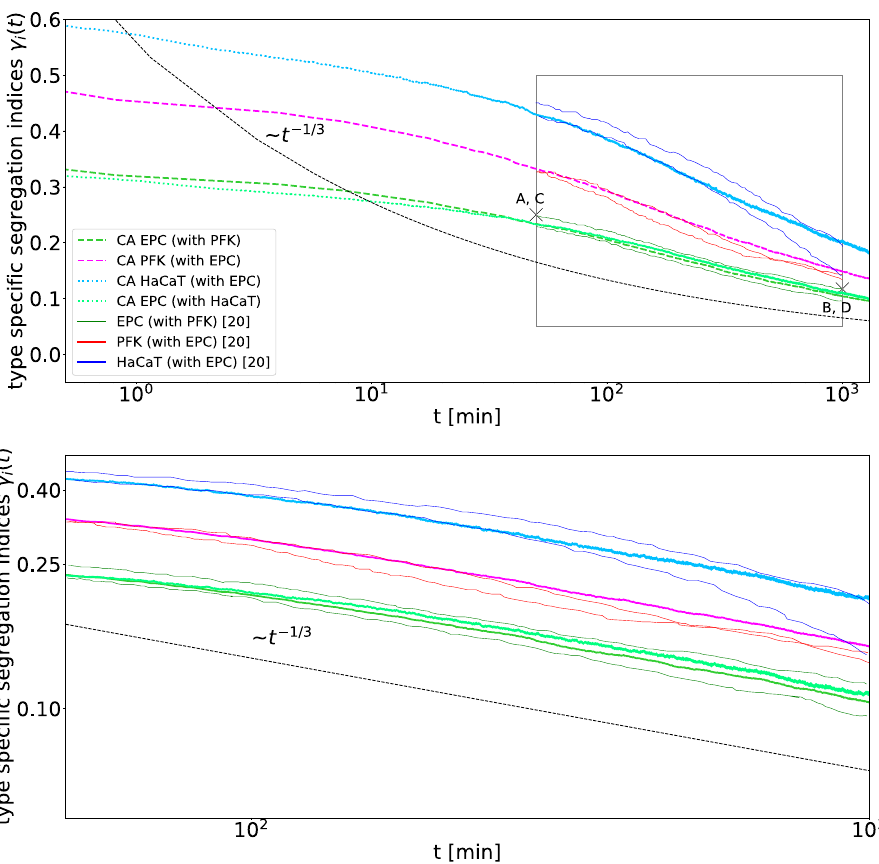
Fig 1. The cellular automaton simulations reproduce the biological cell segregation experiments of Me´hes et al. [20]. The segregation indices γ ( t ) for the two experiments PFK (dark red) with EPC (dark green) and HaCaT (dark i blue) with EPC, within the observed time interval 50–1000 min, match with the segregation indices predicted by the cellular automaton (lines with corresponding brighter colors, dashed lines for PFK with EPC and dotted lines for HaCaT with EPC). Within the given time interval (grey box in top panel displayed again in bottom panel), the segregation indices seem to decay algebraically with exponent 1/3 (black dashed line) as expected asymptotically for fluid segregation. For the simulation of the segregation indices γ i ( t ) of PFK ( i = PFK) mixed with EPC ( i = EPC), we obtain a cell type ratio of N PFK / N EPC = 41.2/58.8 and fit the adhesion parameters ( β PFK-PFK , β EPC-PFK , β EPC-EPC ) = ( − 8.06, − 6.56, − 0.06) and the time scale of migration τ PFK-EPC � 4.2 min. For the simulation of the segregation indices γ i ( t ) of HaCaT ( i = HaCaT) mixed with EPC ( i = EPC) we obtain a cell type ratio of N HaCaT / N EPC = 35.2/64.8 and fit the parameters ( β HaCaT-HaCaT , β EPC-HaCaT , β EPC-EPC ) = ( − 7.93, − 5.44, 0.06) and τ EPC-HaCaT � 35.1 min. In both cases 140 2 cells are simulated, comparable to the cells visible in the experiments, starting from a random mixture. Snapshots of the cell mixtures at the points marked with crosses labeled A, C and B, D are displayed in Fig 3.